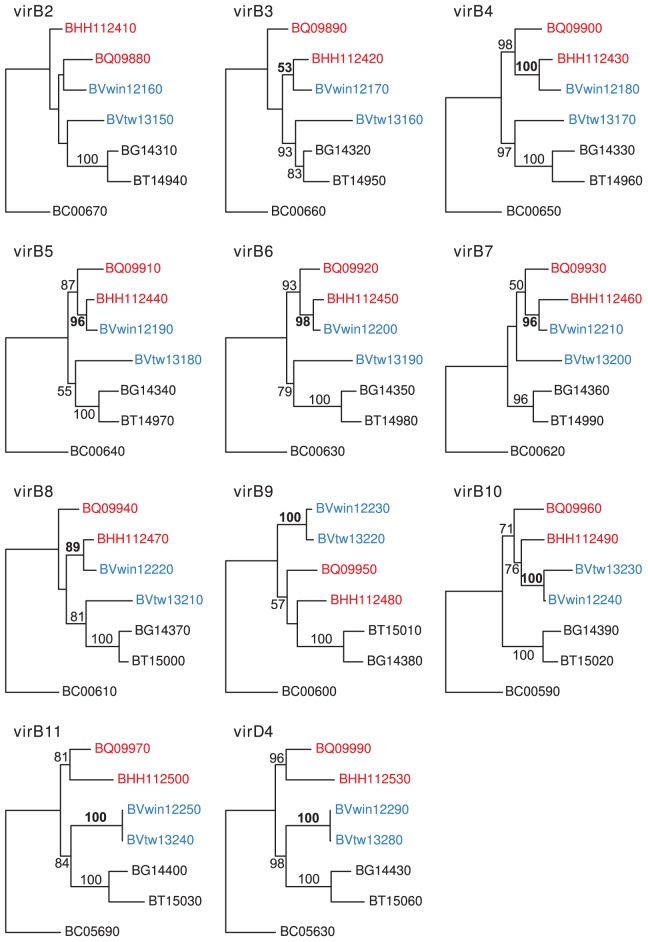
Horizontal gene transfer of the VirB genes across the host species barrier.Individual gene maximum-likelihood phylogenies for genes in the VirB cluster (virB2-virB11 and virD4), based on DNA alignment of all species in the group C, using one of the homologs present in B. clarridgeiae as outgroup. Hundred bootstraps were calculated for each tree. The leaves are the locus ids of the genes in the cluster. Genes in B. henselae Houston-1 and B. quintana are shown in red, genes in B. vinsonii berkhoffii strains Winnie and Tweed are shown in blue, and genes in B. grahamii, B. tribocorum and B. clarridgeiae are shown in black. Bootstrap support higher than 50 is shown on the corresponding branches. The bootstrap support supporting the clustering of B. vinsonii berkhoffii Winnie with either B. henselae Houston-1 or B. vinsonii berkhoffii Tweed is shown in bold font.